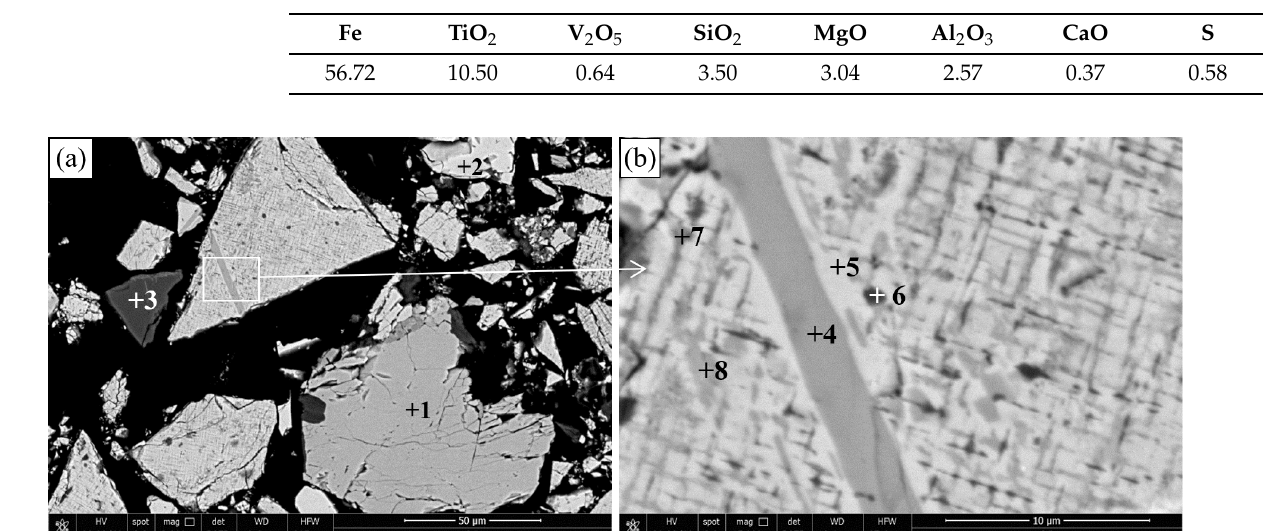
Table 1. Elemental composition of VTMC (mass%).